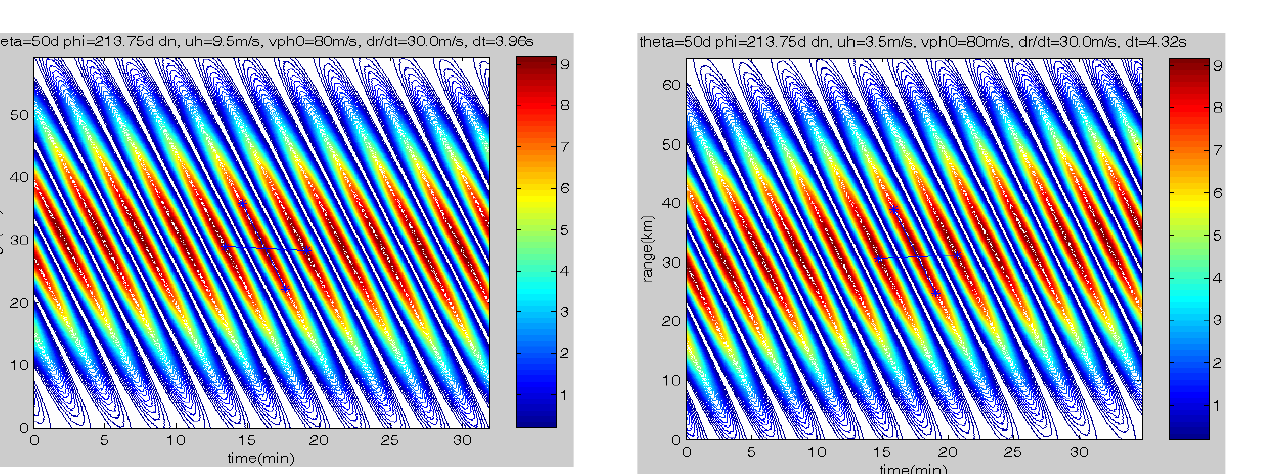
Fig. 5. Same as Fig. 2, except that the preset parameters were: τ 0 = 6 . 0 min, v ph 0 = 80m/s, τ b = 5 . 0 min, u h = 3.5m/s, H = 8km, θ = 50 ◦ , and φ = 213 . 75 ◦ = τ 0 Fig.5 Same as Fig.2 except the preset parameters were: